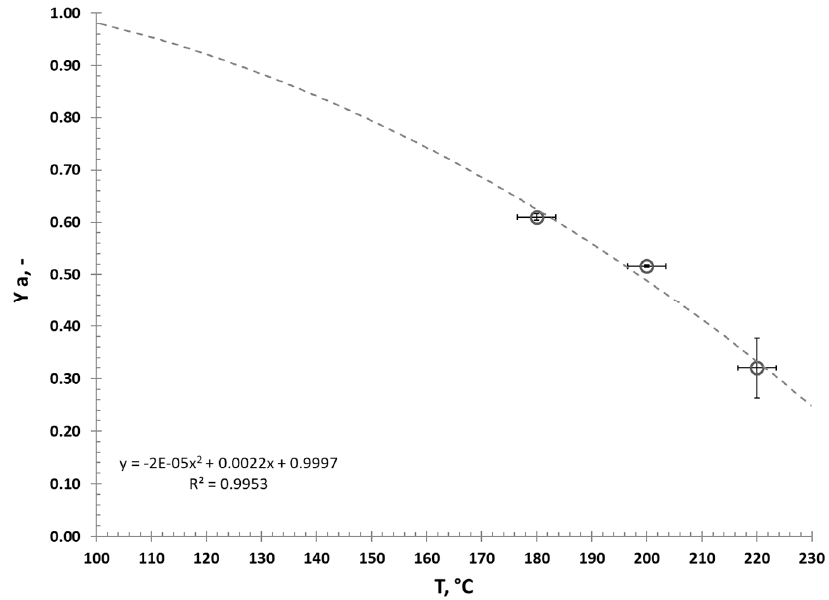
Figure 4. Energy yield for the performed HTC experiments.